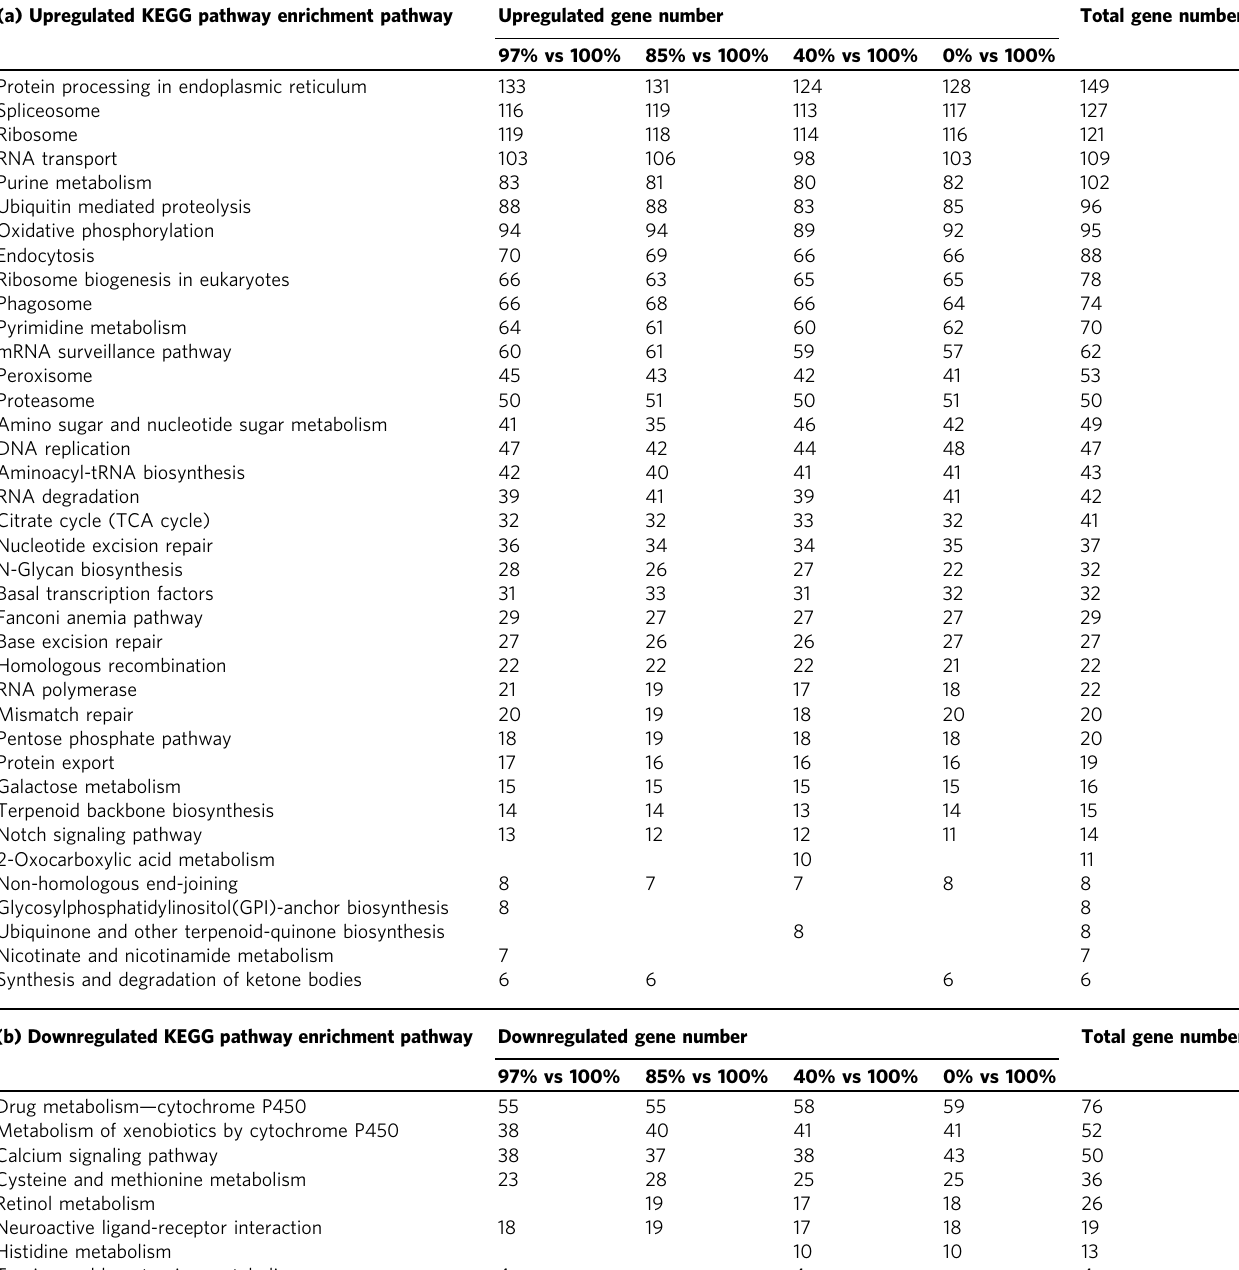
Table 1 KEGG pathway enrichment of differentially regulated genes during anhydrobiosis. (a) Upregulated KEGG pathway enrichment pathway Upregulated gene